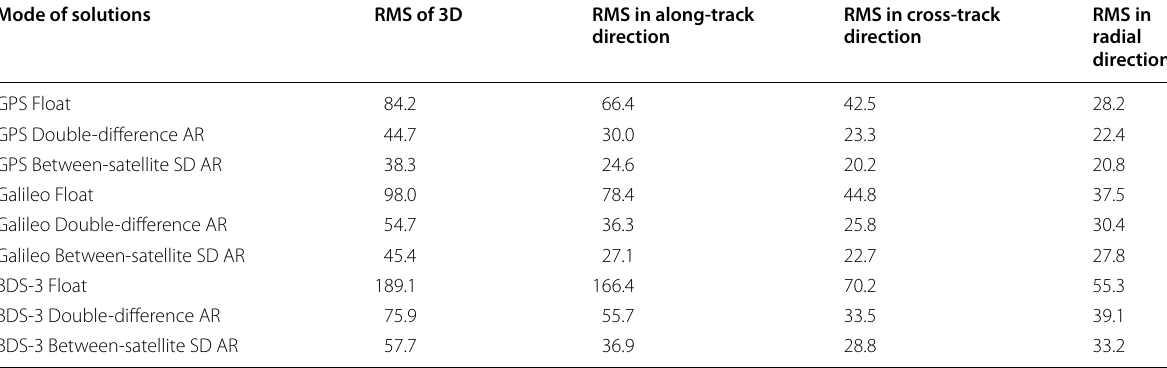
Table 5 RMS of GPS, Galileo, BDS-3 MEO OBDs in each direction (mm) Mode of solutions RMS of